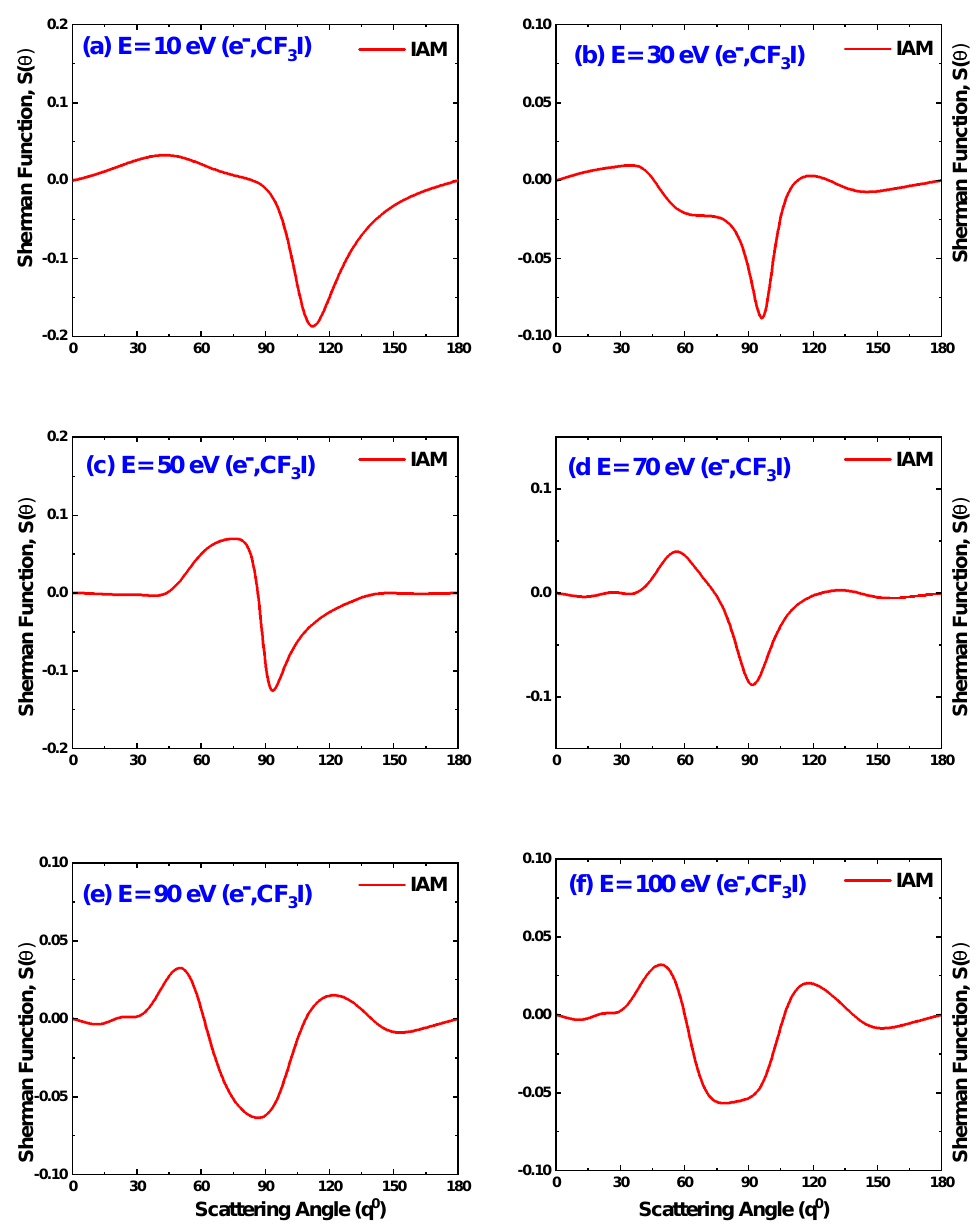
Figure 6. Sherman function for the elastic scattering of electrons from CF 3 I at incident energies 10, 30, 50, 70, 90, and 100 eV. Theoretical works: